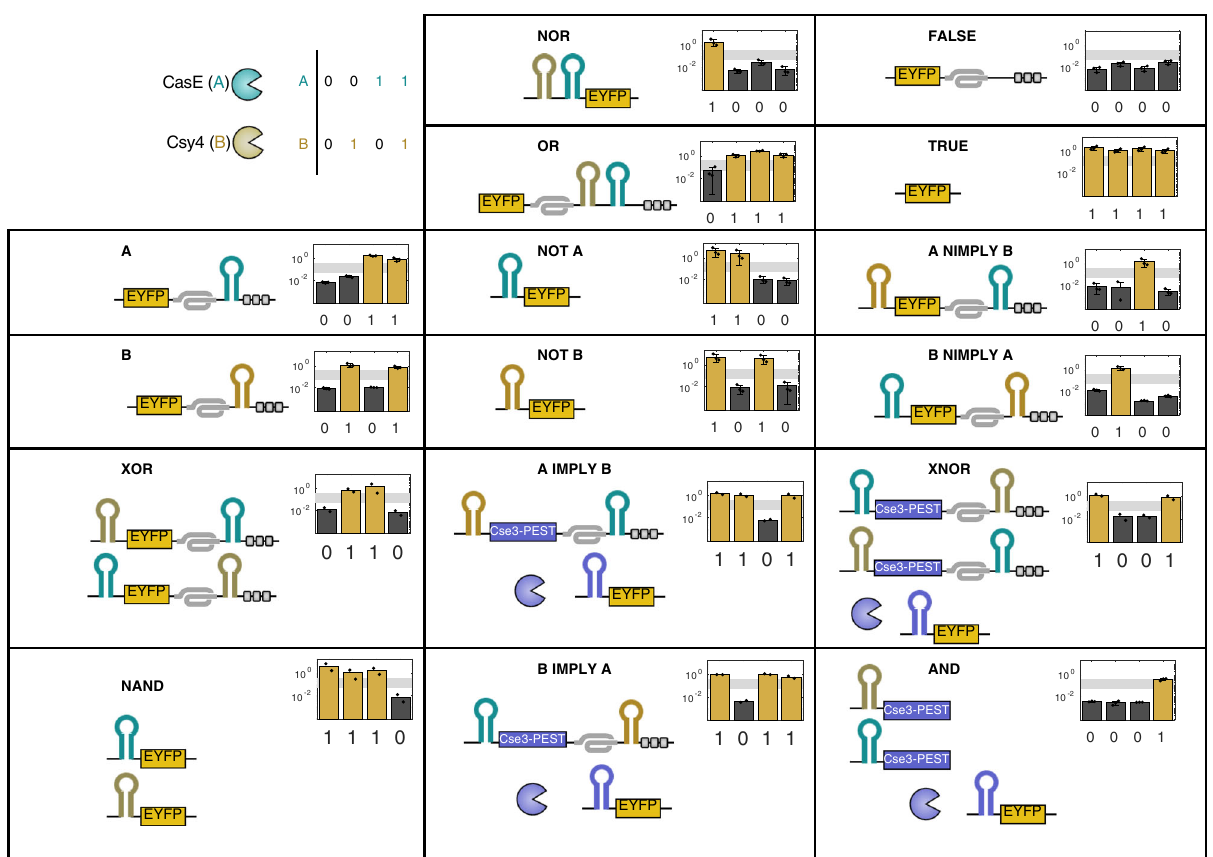
Fig. 3 PERSIST endoRNase platform is modular. All 16 two-input Boolean logic functions can be created using Cas endoRNases and the PERSIST-ON- and OFF-switches. Each logic function was constructed using EYFP as output with other constructs included as necessary to confer a designed response to two inputs: Csy4 and CasE. Cse3 endoRNase was used as an intermediate regulator where necessary. Each set of constructs encoding speci fi c logic functions was evaluated without input endoRNases, with CasE only, with Csy4 only, and with both Csy4 and CasE via poly-transfection (Supplementary Fig. 15). The expected Boolean logic output is depicted below each chart. All logic functions can be correctly identi fi ed using the same approximately 10-fold separation between ON and OFF values (gray region). n = 2 or n = 3 biologically independent samples as indicated by the points where each sample represents the evaluation of >1000 transfected cells (HEK293FT). Data bars are presented as mean normalized